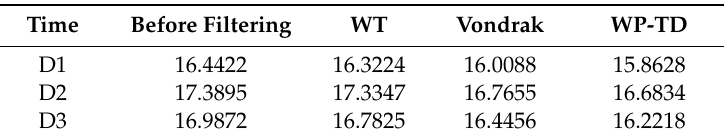
Table 5. RMS value of the DD coordinate residual sequences before and after filtering by the three algorithms